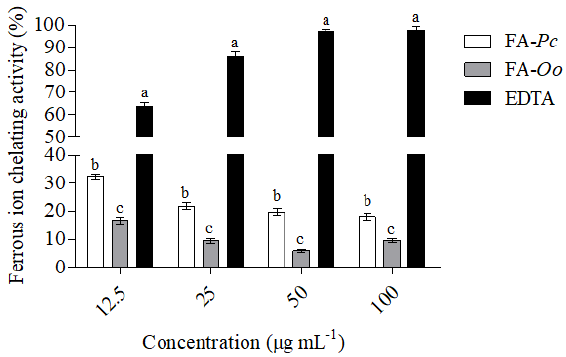
Figure 3 - Ferrous ions chelating activity (FIC) of fatty acids (FA) present in the hexane extract from marine red algae Pterocladiella capillacea ( Pc ) and Osmundaria obtusiloba ( Oo ).